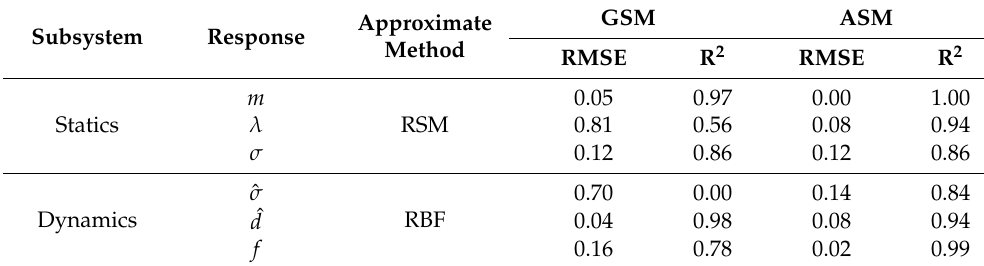
Table 4. Surrogate model error